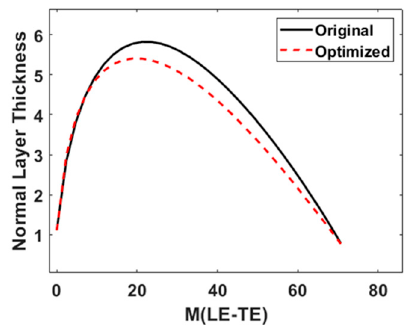
Figure 9. Thickness distribution curves.